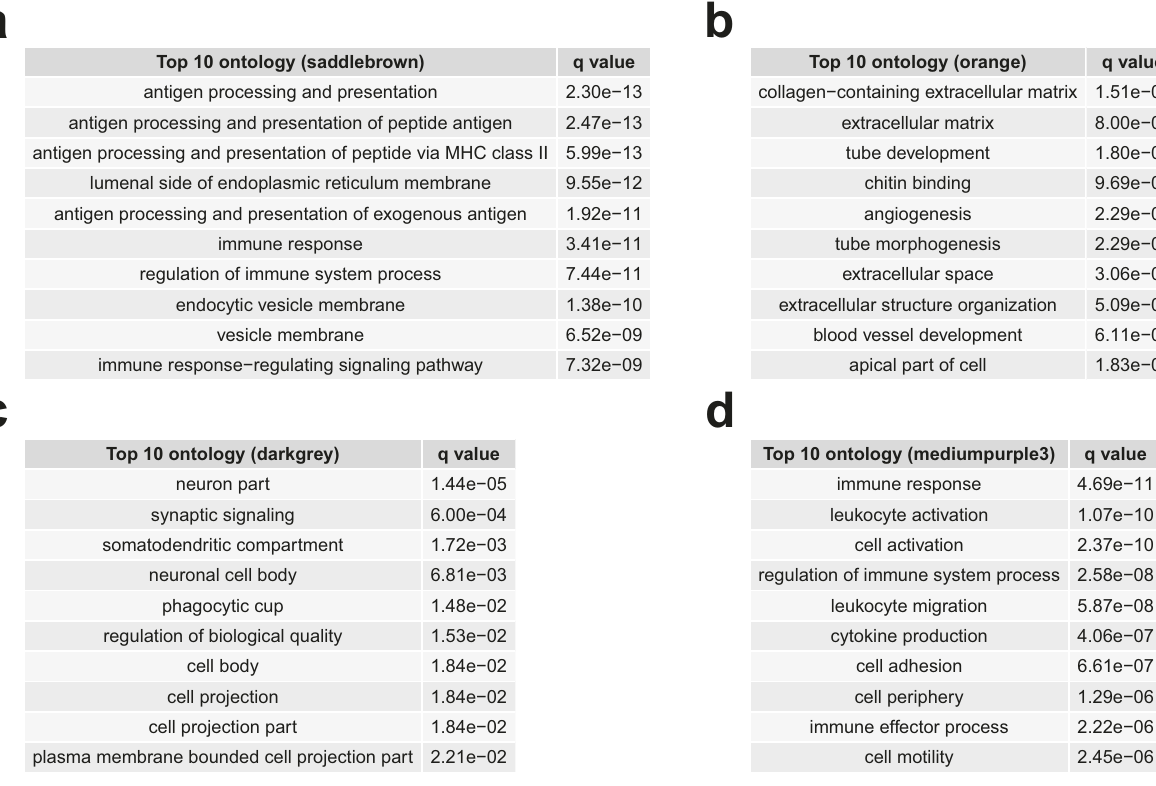
Fig. 4 Module ontology analysis suggests cell type speci fi city. The top 10 ontology groups for saddlebrown ( a ), orange ( b ), darkgrey ( c ), and mediumpurple3 ( d ) are displayed, along with an FDR-adjusted q value that is based on all ontology group one-sided Fisher ’ s exact test p values that were tested (see Supplementary Data 6 for full ontology analysis for these four modules, including all p values and FDR-adjusted q